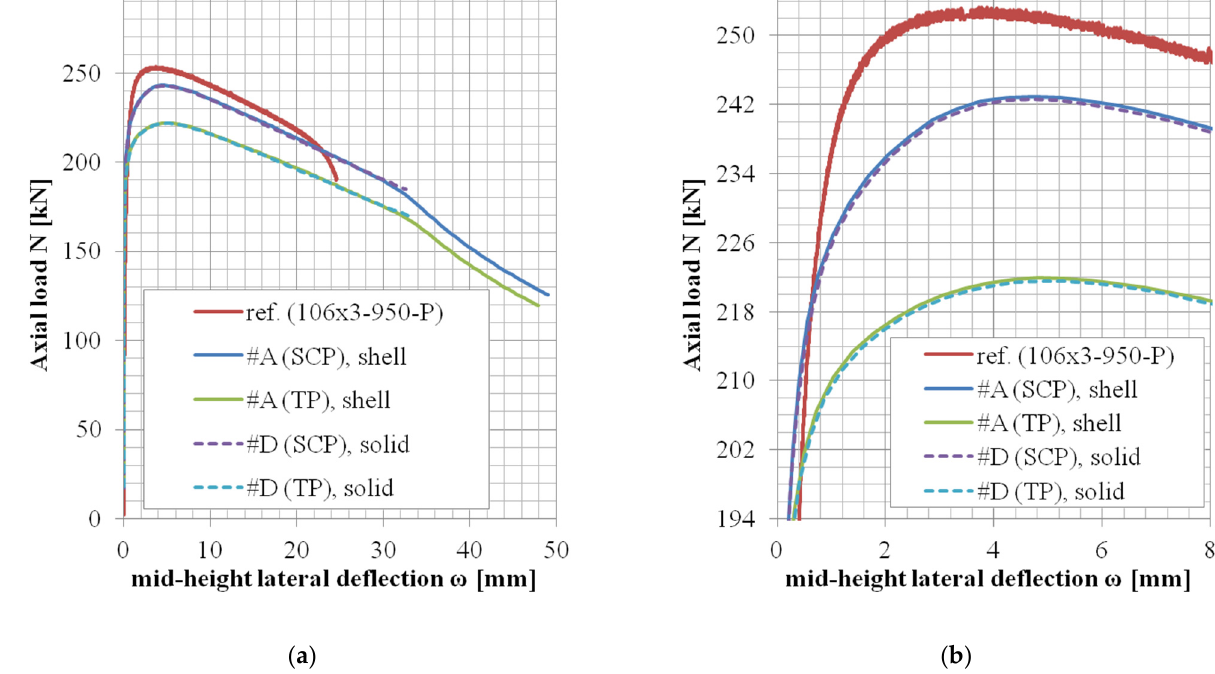
Figure 7. Experimental and FE loads vs. midheight lateral deflection curves of 106 × 3-950-P [38]: ( a ) whole; ( b ) zoomed.